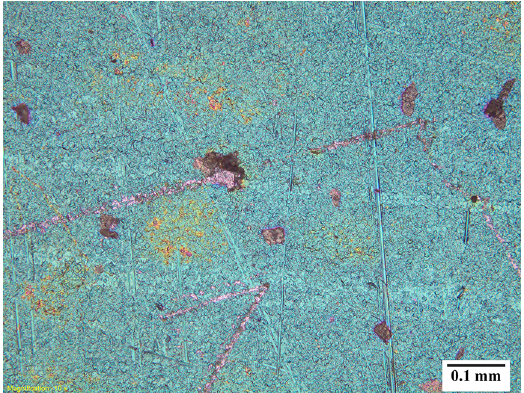
Figure 3. Optical microscopy of silicon film deposited on Ti-6Al- 4V substrate for 1